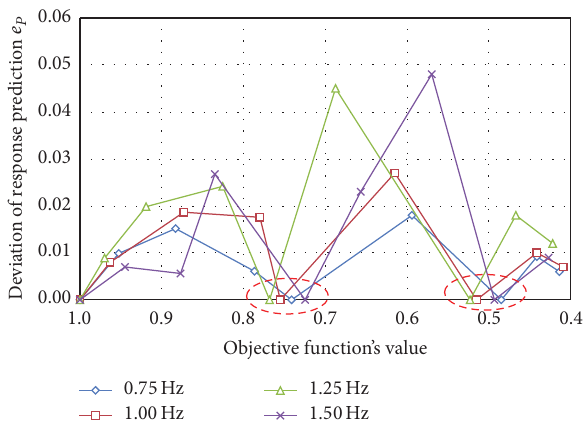
Figure 9: The deviation of predicted gust response with calibration process for different gust frequencies.